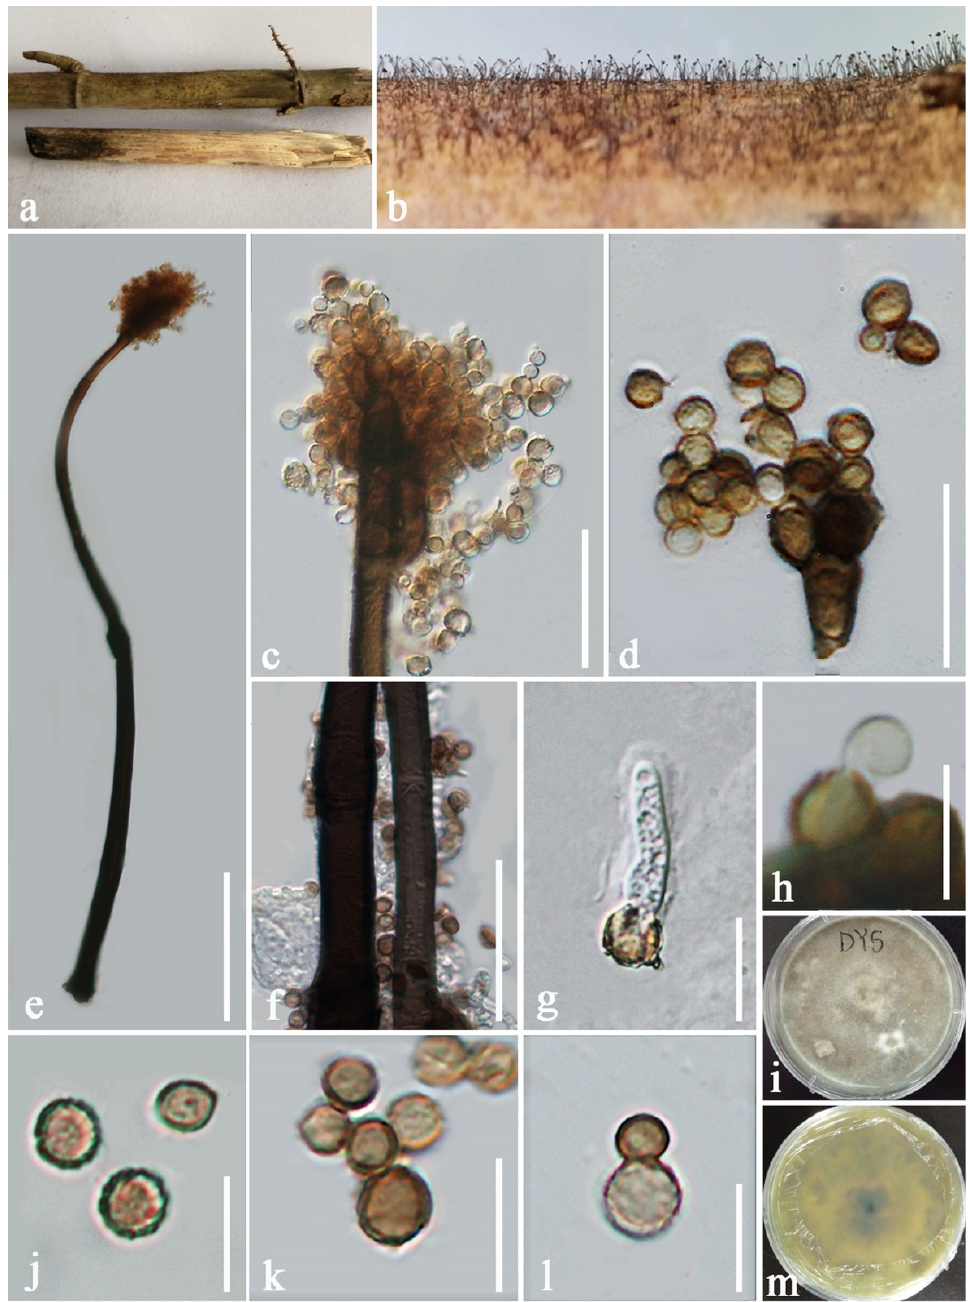
Figure 8. Periconia thysanolaenae (KUN-HKAS 107381, holotype) ( a ) Dead culms of Thysanolaena latifolia (Poaceae); ( b ) close-up of conidiophores on host substrate; ( c ) apical branch conidiophores with conidial head; ( d ) polyblastic conidiogenous cells bearing catenate conidia; ( e ) a conidiophore; ( f ) close-up base of the conidiophores; ( g ) germinated conidium; ( h ) conidiogenous cell with developing conidium on upper fertile part; ( j ) single conidia; ( k , l ) catenate conidia; ( i , m ) colony from above and below. Scale bars: ( e ) = 100 µm, ( c ) = 30 µm, ( f , d ) = 20 µm, ( j ) = 10 µm, ( g , h , k , l ) = 5 µm.